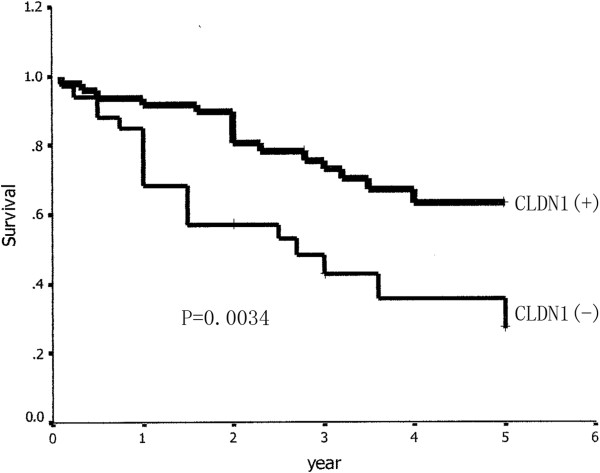
Relationship between expression of CLDN1 and survival of patients with lung adenocarcioma. Patients with positive CLDN1 expression had a better survival than those with negative expression (P = 0.0034).